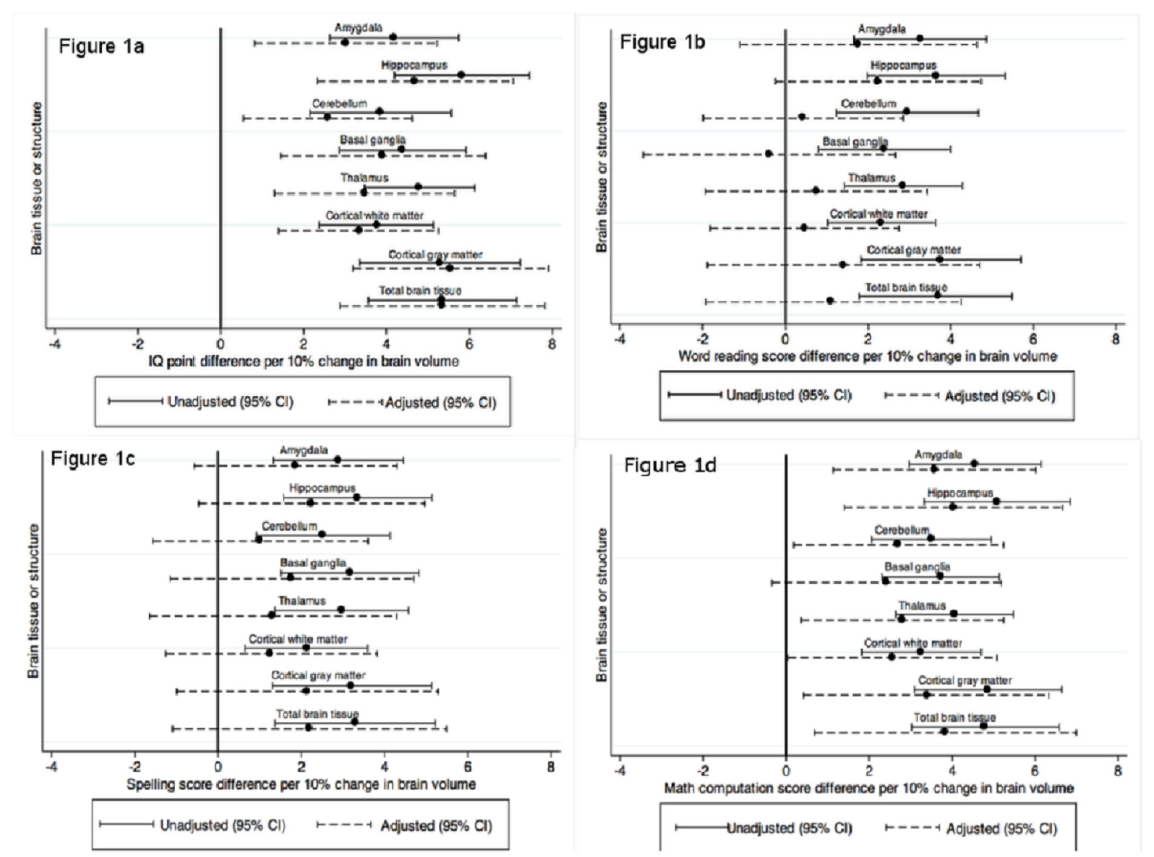
Figure 1. Relationships between brain tissue volumes and IQ/educational outcomes. Relationships between brain volumes of multiple tissues and structures with IQ (Figure 1a), word reading (Figure 1b), spelling (Figure 1c) and math computation (Figure 1d) scores, with data from extremely preterm and control subjects combined. The solid lines represent unadjusted analyses; the dashed lines represent analyses adjusted for sex, maternal education and social class. The x-axis shows score difference for every 10% difference in brain volume, relative to the volume of the particular brain region in controls. CI – confidence interval. doi: